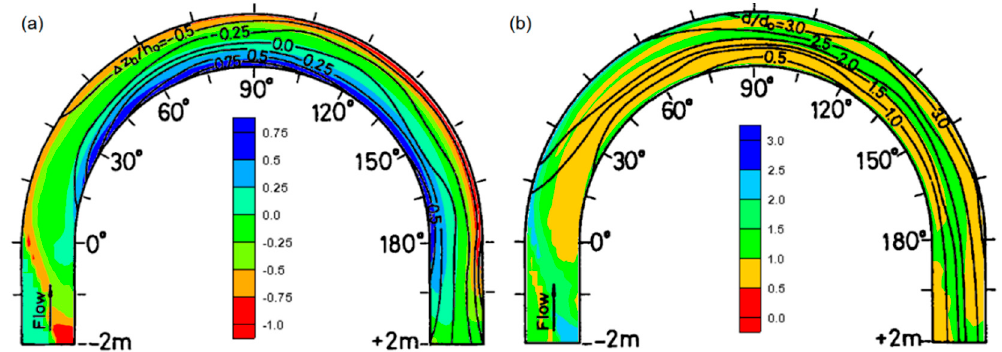
Figure 10. Measured (isolines) and HYDRO-FT calculated (colored) contours: ( a ) bed evolutions normalized by the initial water depth ( h 0 = 0.0544 m); ( b ) median sediment size normalized by the initial median diameter.